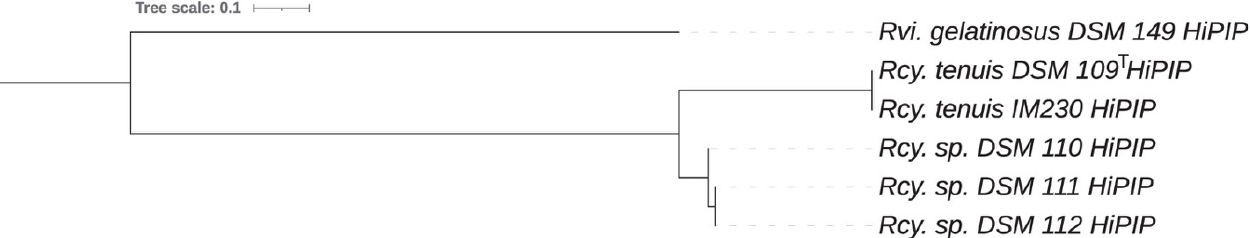
Figure 4. Phylogenetic tree of the HiPIP protein sequences obtained from the Rhodocyclus genomes. Rubrivivax gelatinosus DSM 149 HiPIP was used as an outgroup.